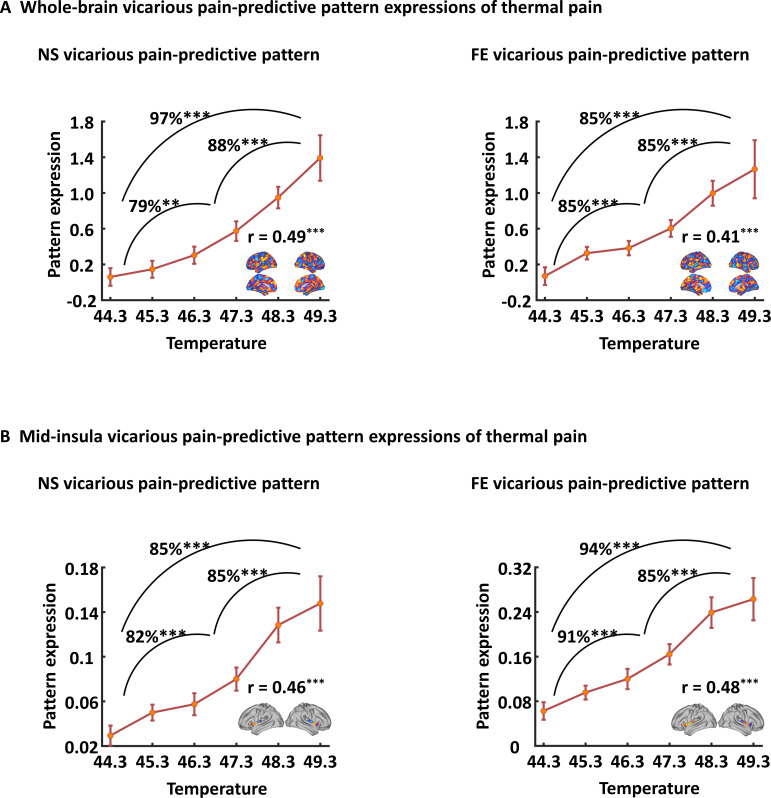
Generalizability of the NS and FE vicarious pain-predictive patterns.Both whole-brain (A) and mid-insula (B) vicarious pain-predictive patterns could accurately predict the severity and classify the levels of self-experienced pain in an independent dataset. NS vicarious pain, observation of noxious stimulation of body limbs induced vicarious pain; FE vicarious pain, observation of facial expressions of pain induced vicarious pain. r indicates correlation coefficient between pattern expression and temperature levels. **p < 0.01; ***p < 0.001.